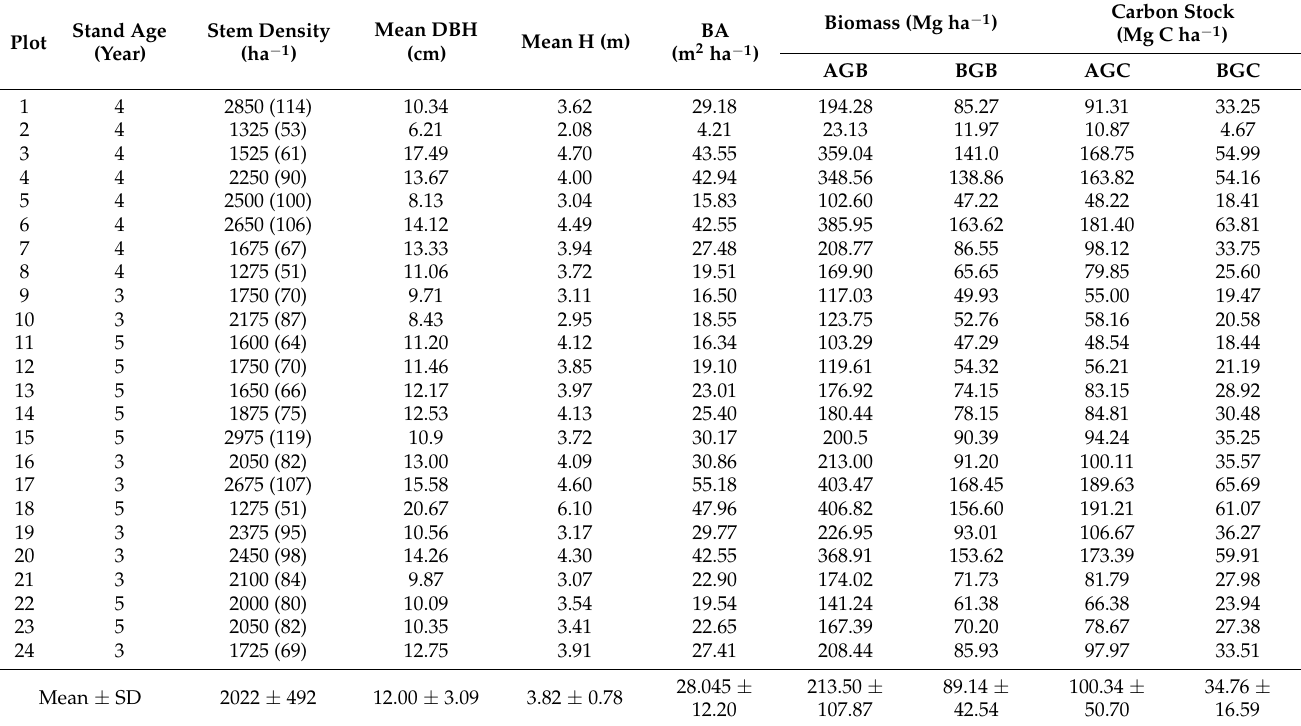
Table A1. Structural characteristics and biomass in each plot in the study